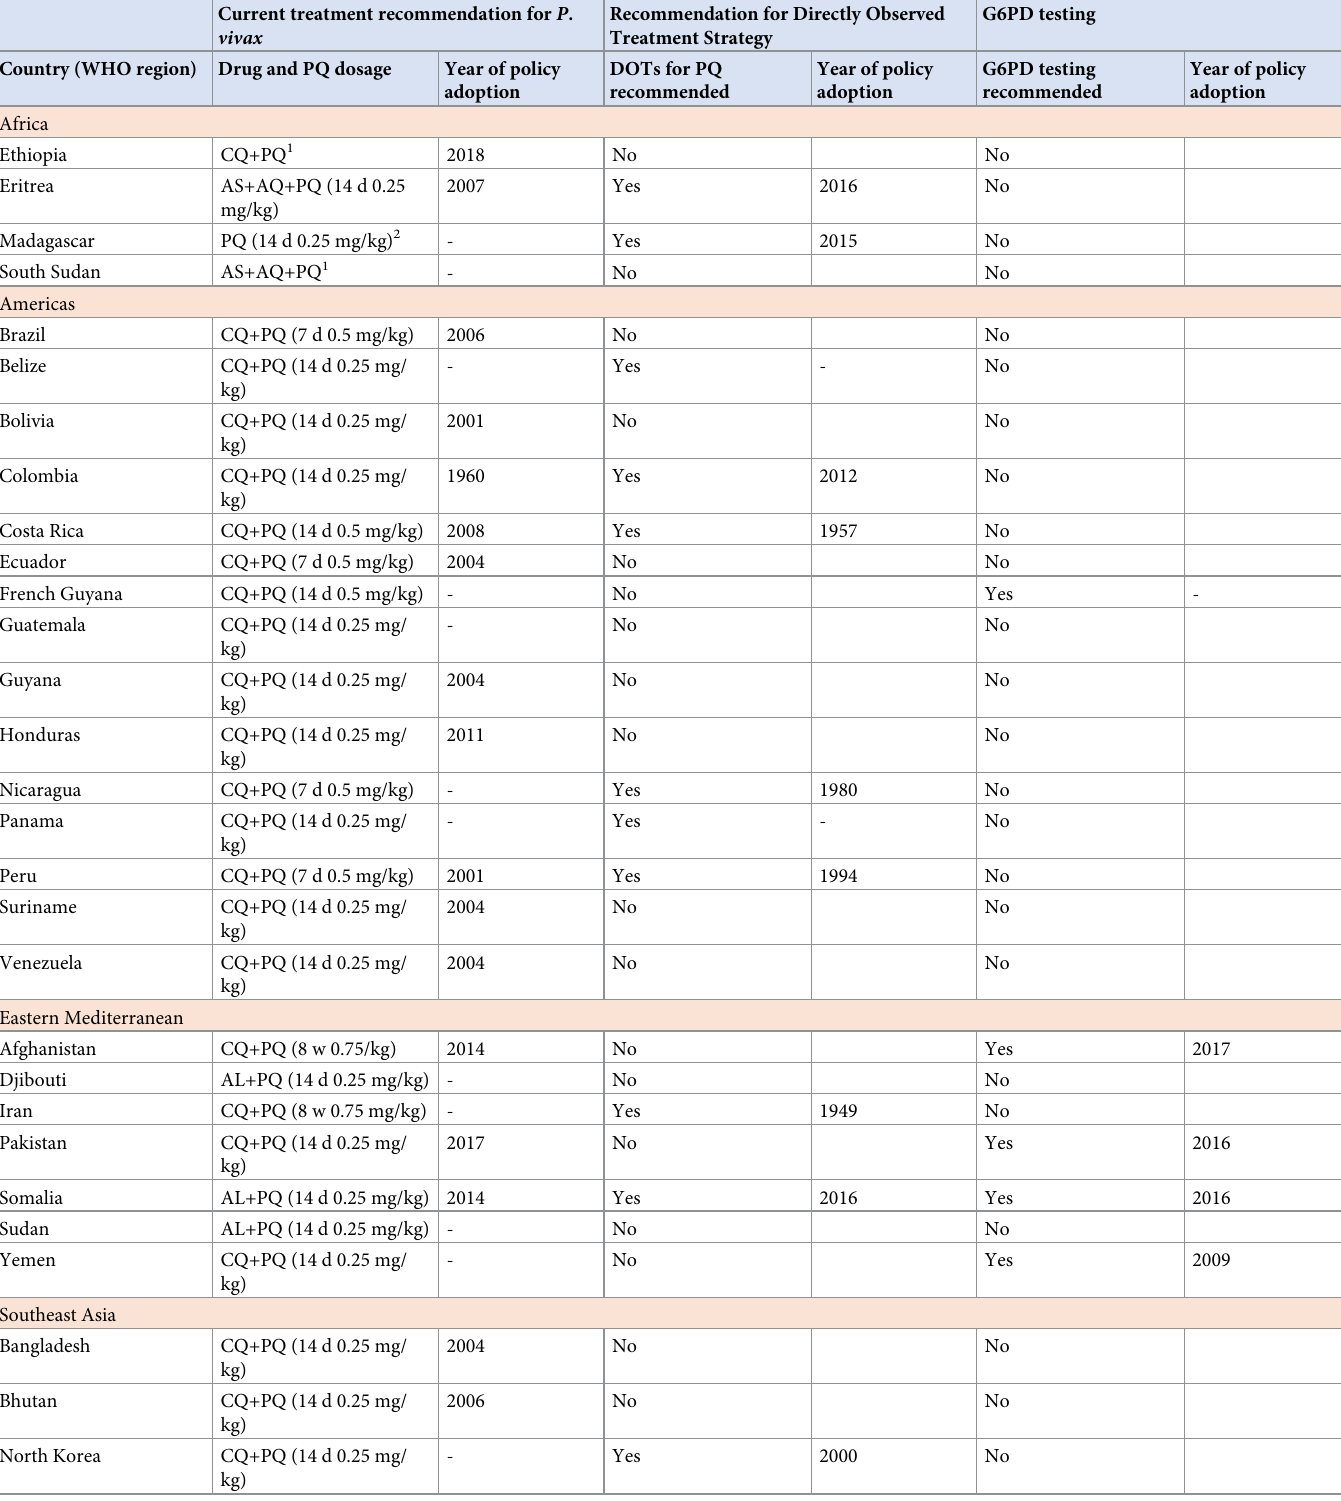
Table 1. Overview of current policy recommendation by country based on WHO 2018 World Malaria